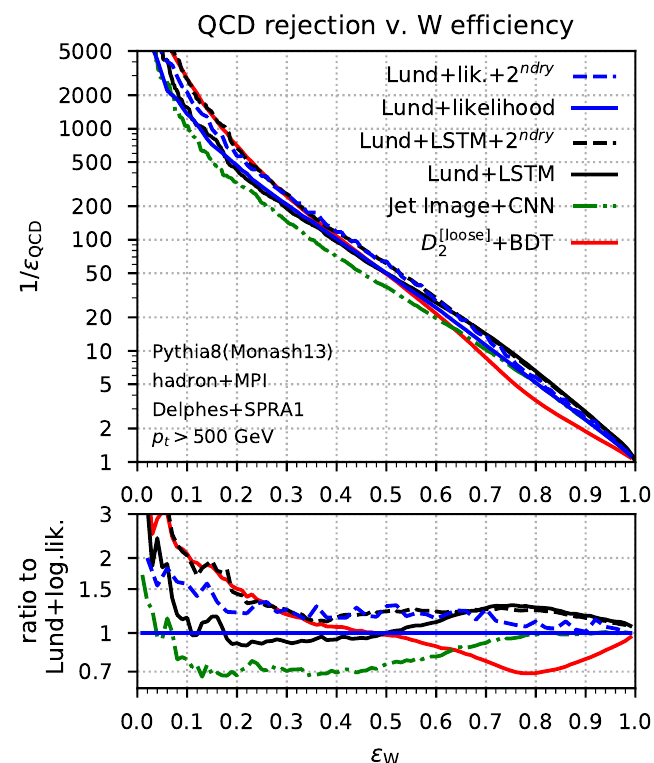
Figure 15. Background rejection (1 =(cid:15) QCD ) versus signal e(cid:14)ciency ( (cid:15) W ), with a transverse momen- tum cut on the jets of 500 GeV. The lower panel shows the ratio to the Lund+likelihood method. The solid curves are to be compared to the corresponding ones in (cid:12)gure 10 for jets with p t > 2 TeV (note the di(cid:11)erent scale in the lower